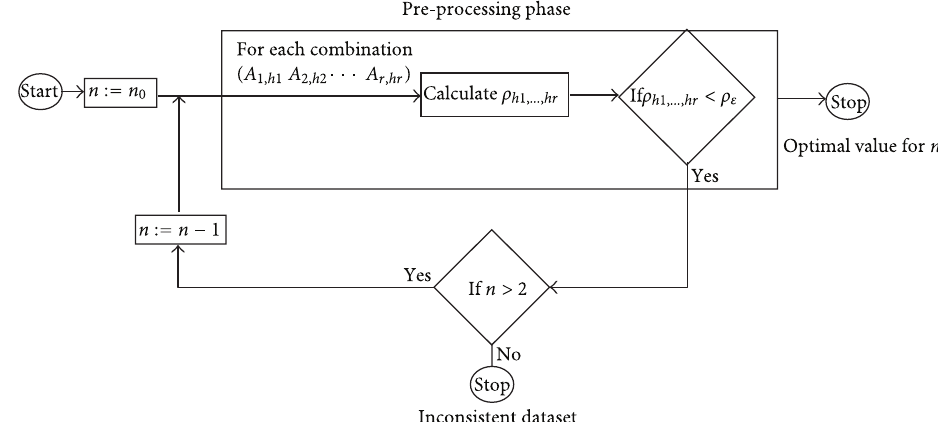
Figure 4: Schema of the pre-processing